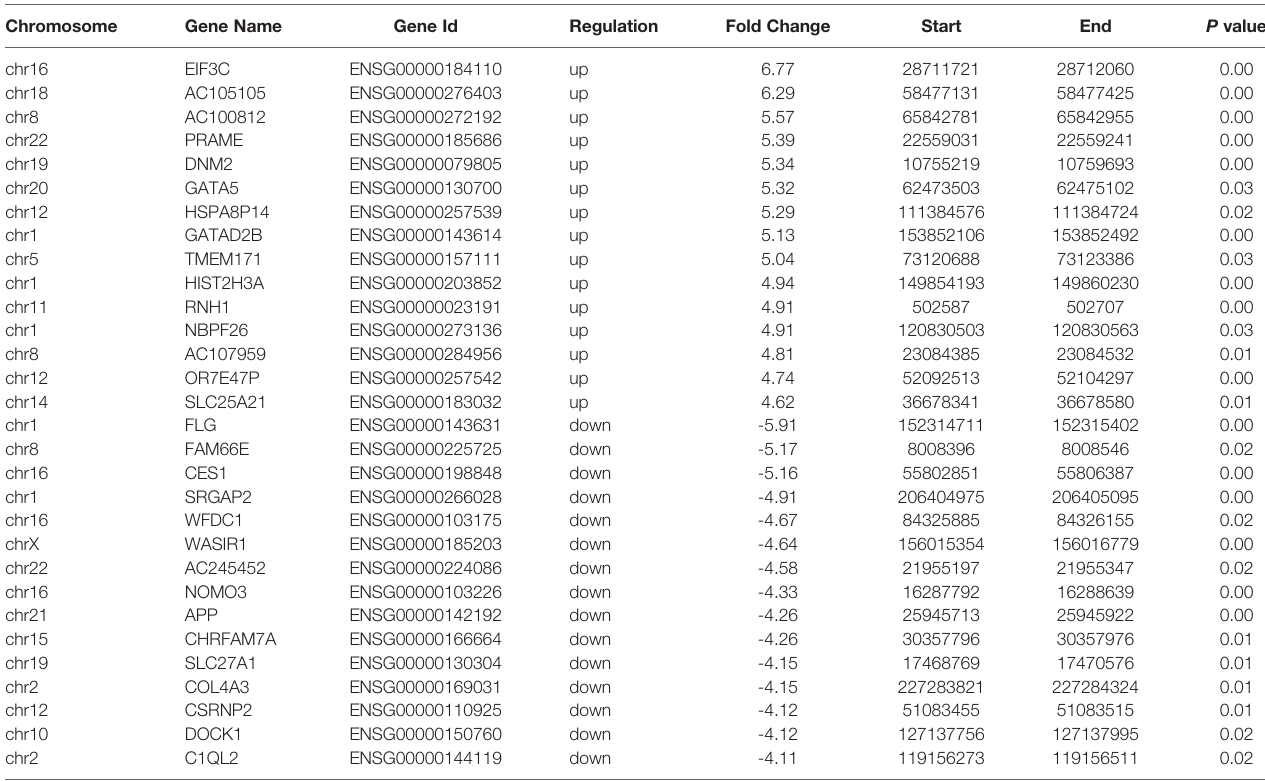
TABLE 1 | The top 30 differently methylated m6A peaks (EOC vs OE).